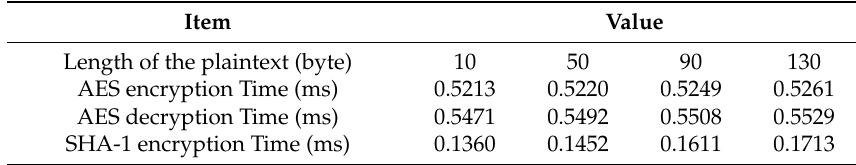
Table 6. Execution time of AES and SHA-1 on Raspberry Pi 3B.